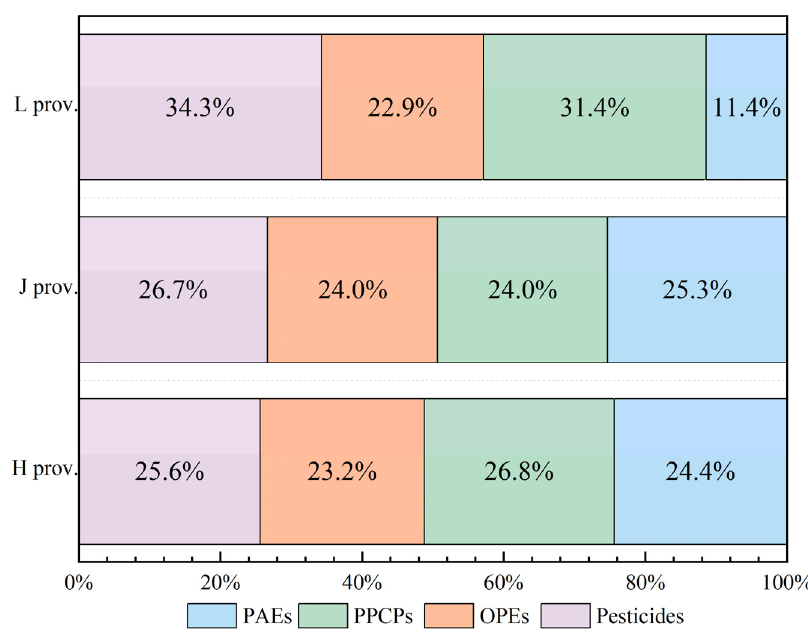
Figure 12. Relative composition of organic micropollutants in different regions.